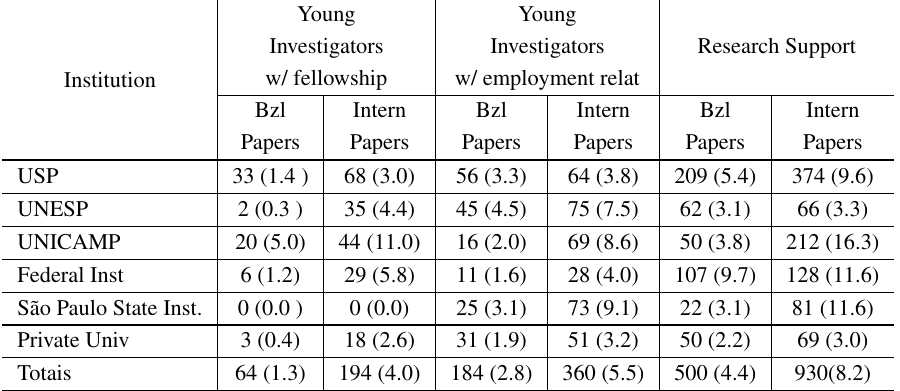
Papers published after the completion of YI and RS projects. Survey conducted in March